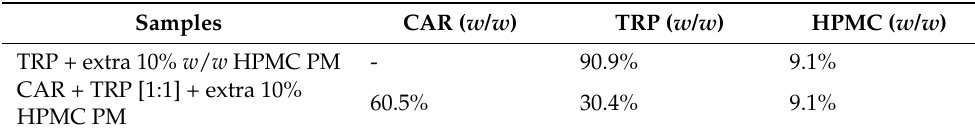
Table 2. Weight ratios of the binary and ternary physical